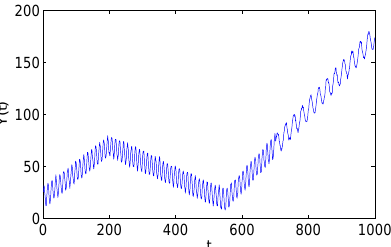
Fig. 5. Time series composed of the linear functions and the sine functions.